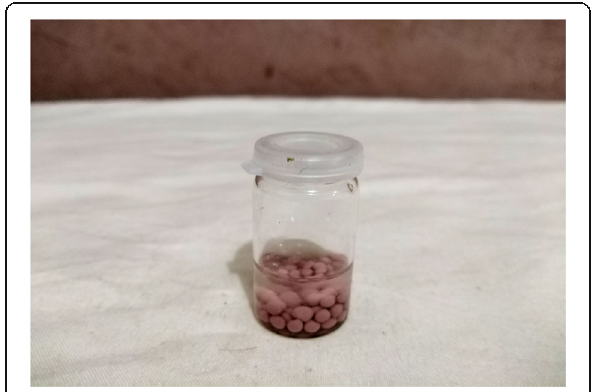
Fig. 2 α -Amylase immobilization on Ch-MNP/PEI/GA beads